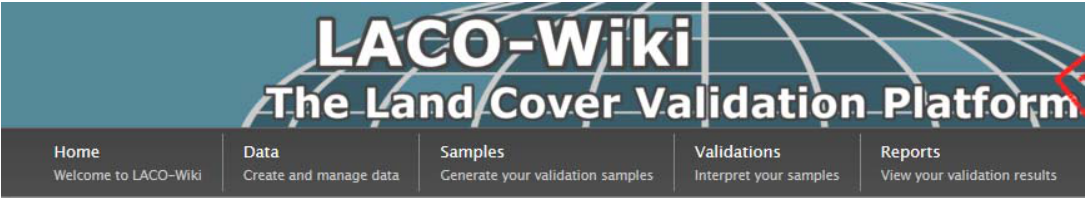
Figure 3. The LACO-Wiki interface (http://www.laco-wiki.net) showing the four components of the validation workflow as menu items at the top of the screen.